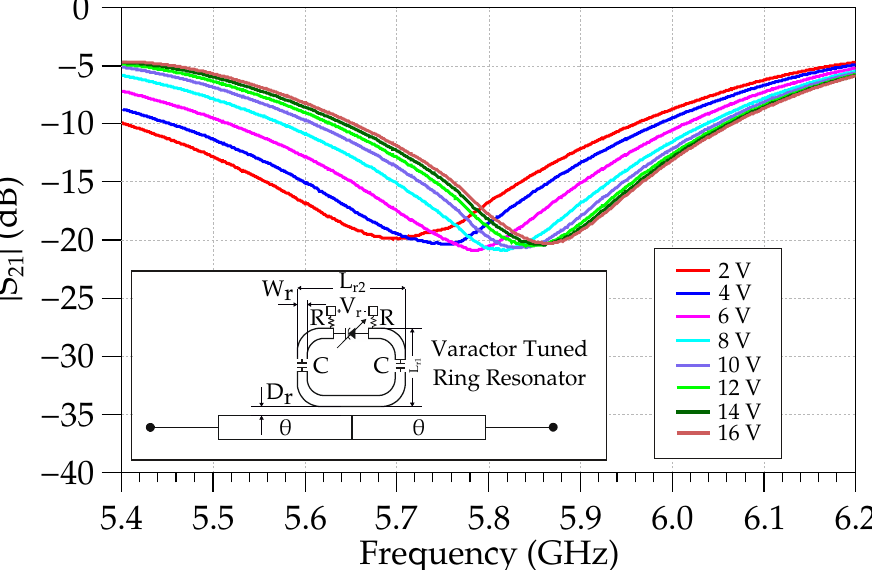
Figure 3. Measured response of the subsections composing the DR tuneable filter: the response of the tuneable